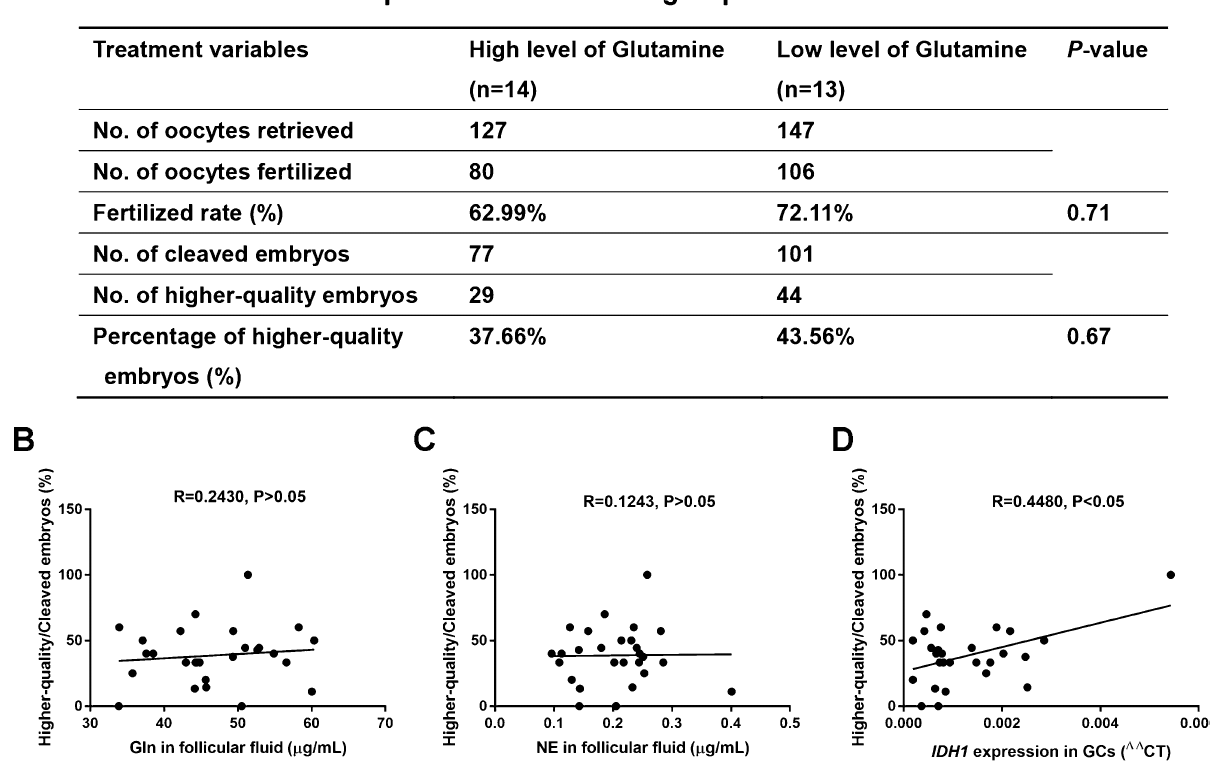
Figure 5. The correlation between glutamine (Gln) or norepinephrine (NE) concentration in follicular fluid and the outcome of in vitro fertilization patients. ( A ) Analysis of the treatment variables in the patients between the two groups. ( B ) Correlation analysis of the Gln concentration in the human follicular fluid and the ratio higher-quality/cleaved embryos (n = 27, R = 0.2430, P > 0.05). ( C ) Correlation analysis of the NE concentration in the human follicular fluid and the ratio of higher-quality/cleaved embryos (n = 27, R = 0.1243, P > 0.05). ( D ) A positive correlation between IDH1 gene expression in cumulus granulosa cells (GCs) and the ratio of higher- quality/cleaved embryos (n = 27, R = 0.4480, P <